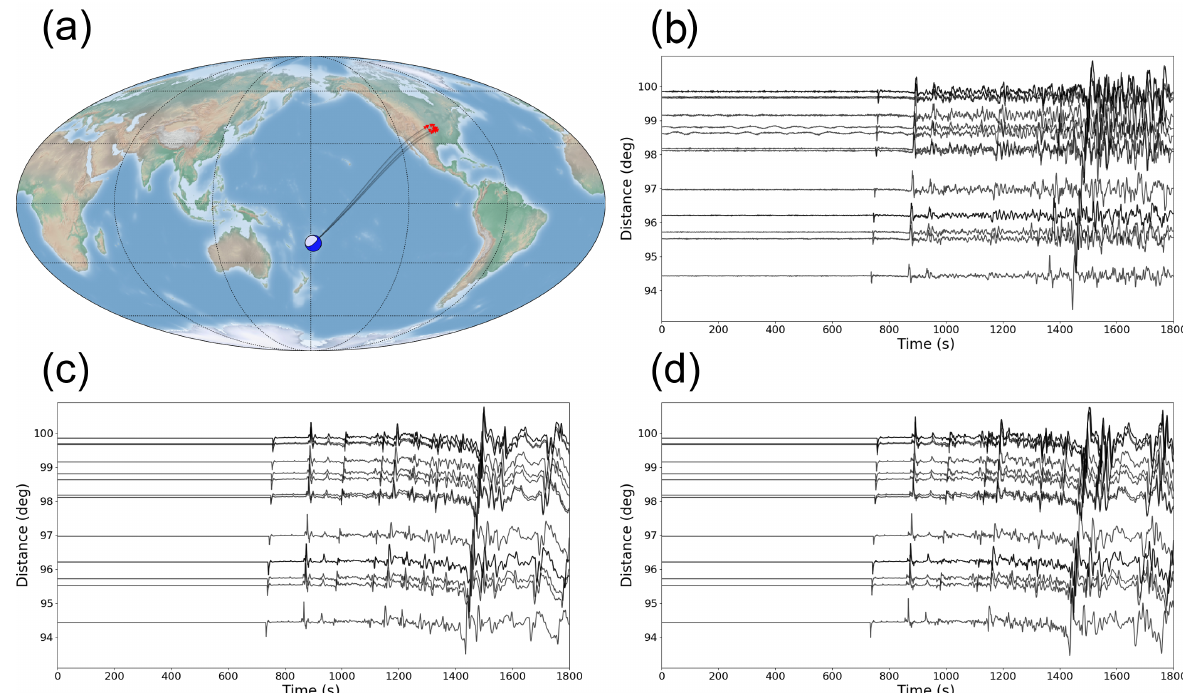
Figure 5. Observed versus modeled broadband seismograms for an earthquake of a magnitude of 6.9 M w in the Fiji Islands region (21 July 2014, 14:54:41, at 19.802 ◦ S, 178.4 ◦ W; 615km depth). (a) Source and receiver distribution plotted by obspyDMT --datapath data_fiji_island --local --plot_ev --plot_focal --plot_sta --plot_ray . Note the distribution of stations with respect to the event. The options flags --min_azi , --max_azi , --min_epi and --max_epi specified minimum azimuth, maximum azimuth, minimum distance and maximum distance for station search, respectively. (b) Observed broadband waveforms plot- ted by obspyDMT --datapath data_fiji_island --local --plot_waveform --plot_dir processed . (c) Syn- thetic seismograms retrieved from the Syngine web service for the PREM anisotropic background model. The stored waveforms are plotted by obspyDMT --datapath data_fiji_island --local --plot_waveform --plot_dir syngine_prem_a_2s . Panel (d) is similar to (c) except for the IASP91 background model. Plotted by obspyDMT --datapath data_fiji_island --local --plot_waveform --plot_dir syngine_iasp91_2s .